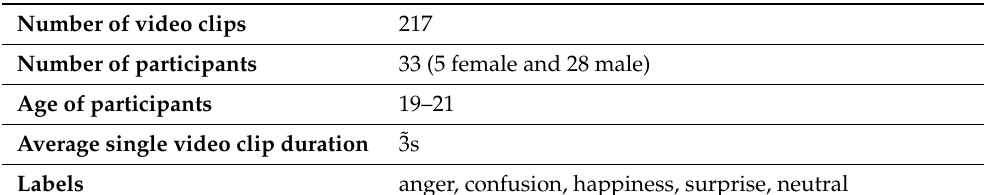
Table 3. Dataset content